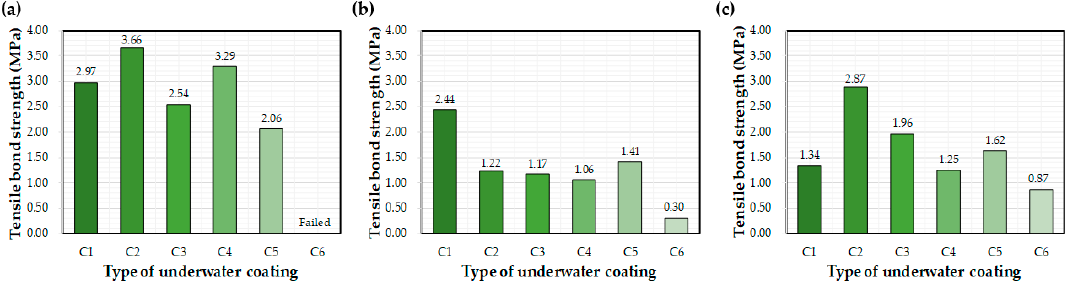
Figure 7. Average bond strength values after 72 h of water exposure: ( a ) control, ( b ) E1, and ( c ) E2.